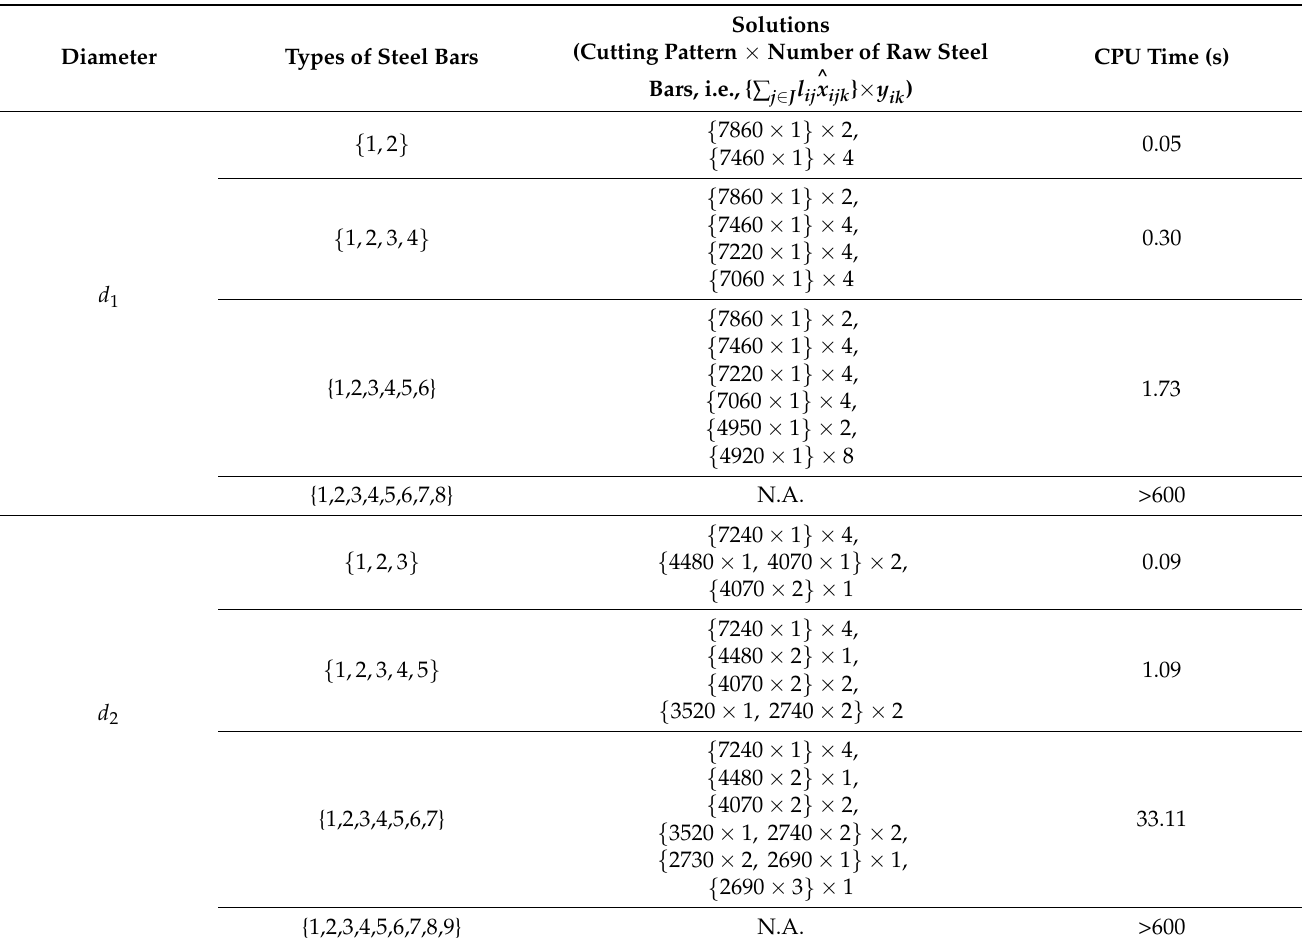
Table 5. Data for the required numbers of steel bars of diameter 12 mm and diameter 18 mm.